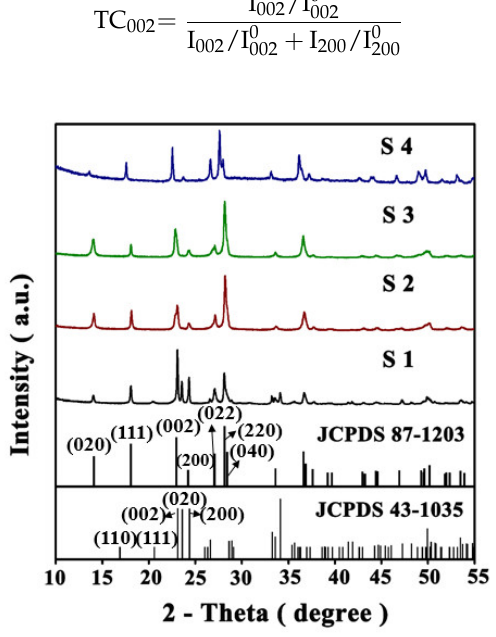
Figure 5. X-ray diffraction (XRD) patterns (2θ = 10°–55°) of S1, S2, S3, S4.